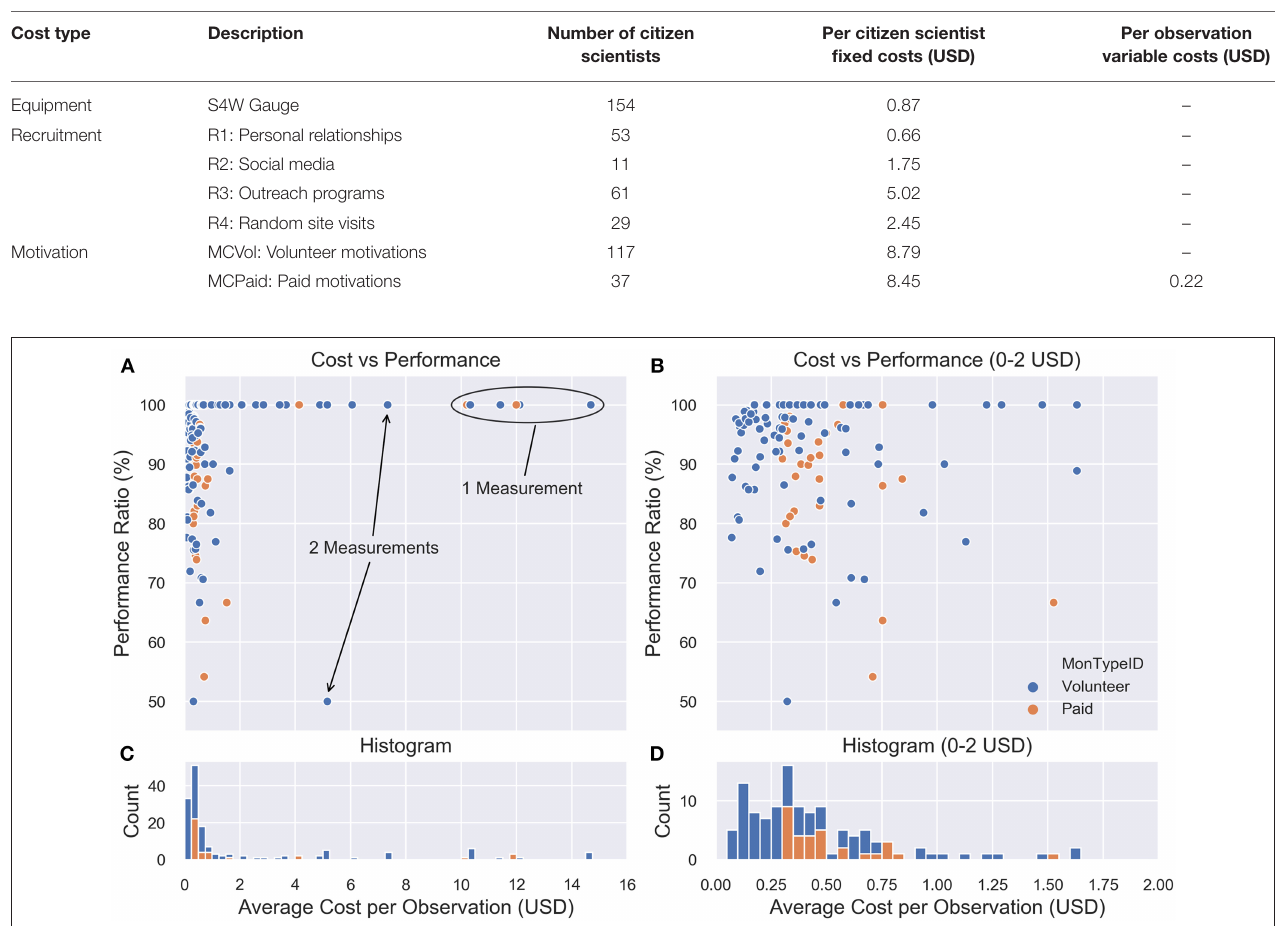
TABLE 4 | Summary of fixed and variable costs for equipment, recruitment, and motivation per citizen scientist, including the number of applicable citizen scientists.